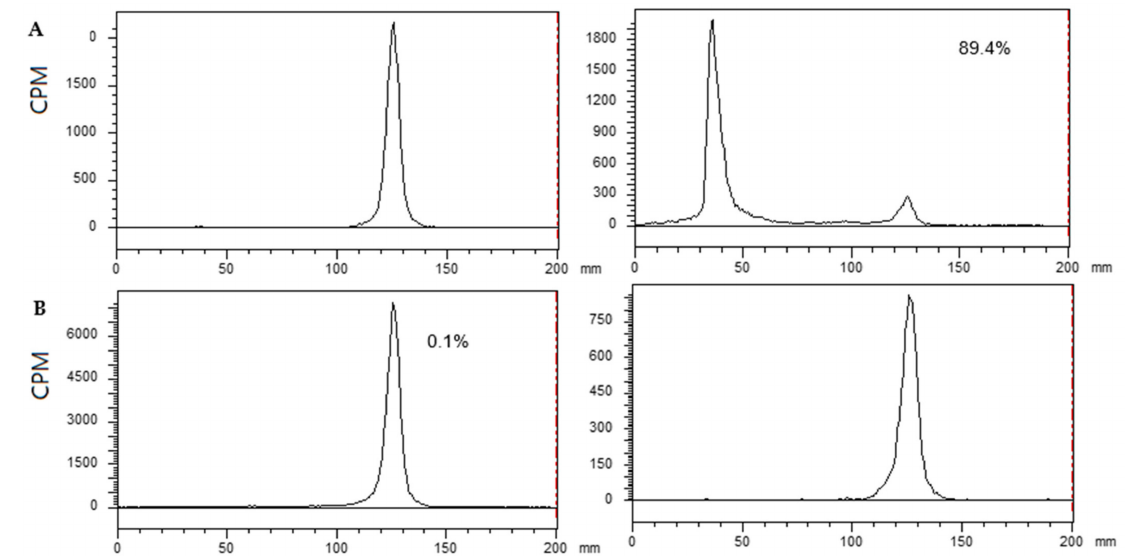
Figure 1. Comparison of insoluble fraction formation. Instant thin layer chromatography-silica gel (ITLC-SG) data eluted with saline. 99m Tc-labeled agents were subjected to reaction with NaHS at 37 ◦ C for 10 min at pH 7.4. The radioactivity remaining at the origin was calculated as the insoluble fraction. ( A ) [ 99m Tc]Tc-Gluconate (left: before reaction; right: after reaction) and ( B ) [ 99m Tc]Tc-DTPA (left: before reaction; right: after reaction).